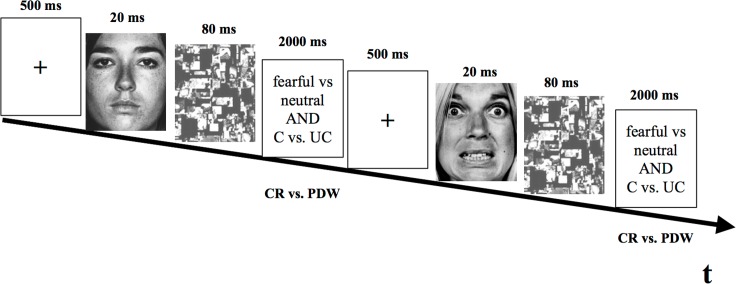
Diagram of experimental procedure of emotional faces identification task with subsequent trials; At each trial a target face (fearful of neutral) was presented, followed immediately by a mask.Then, participants had to discriminate whether a target face was fearful or neutral, and rate their awareness with CR or PDW. Awareness scales were used simultaneously with identification task responses.